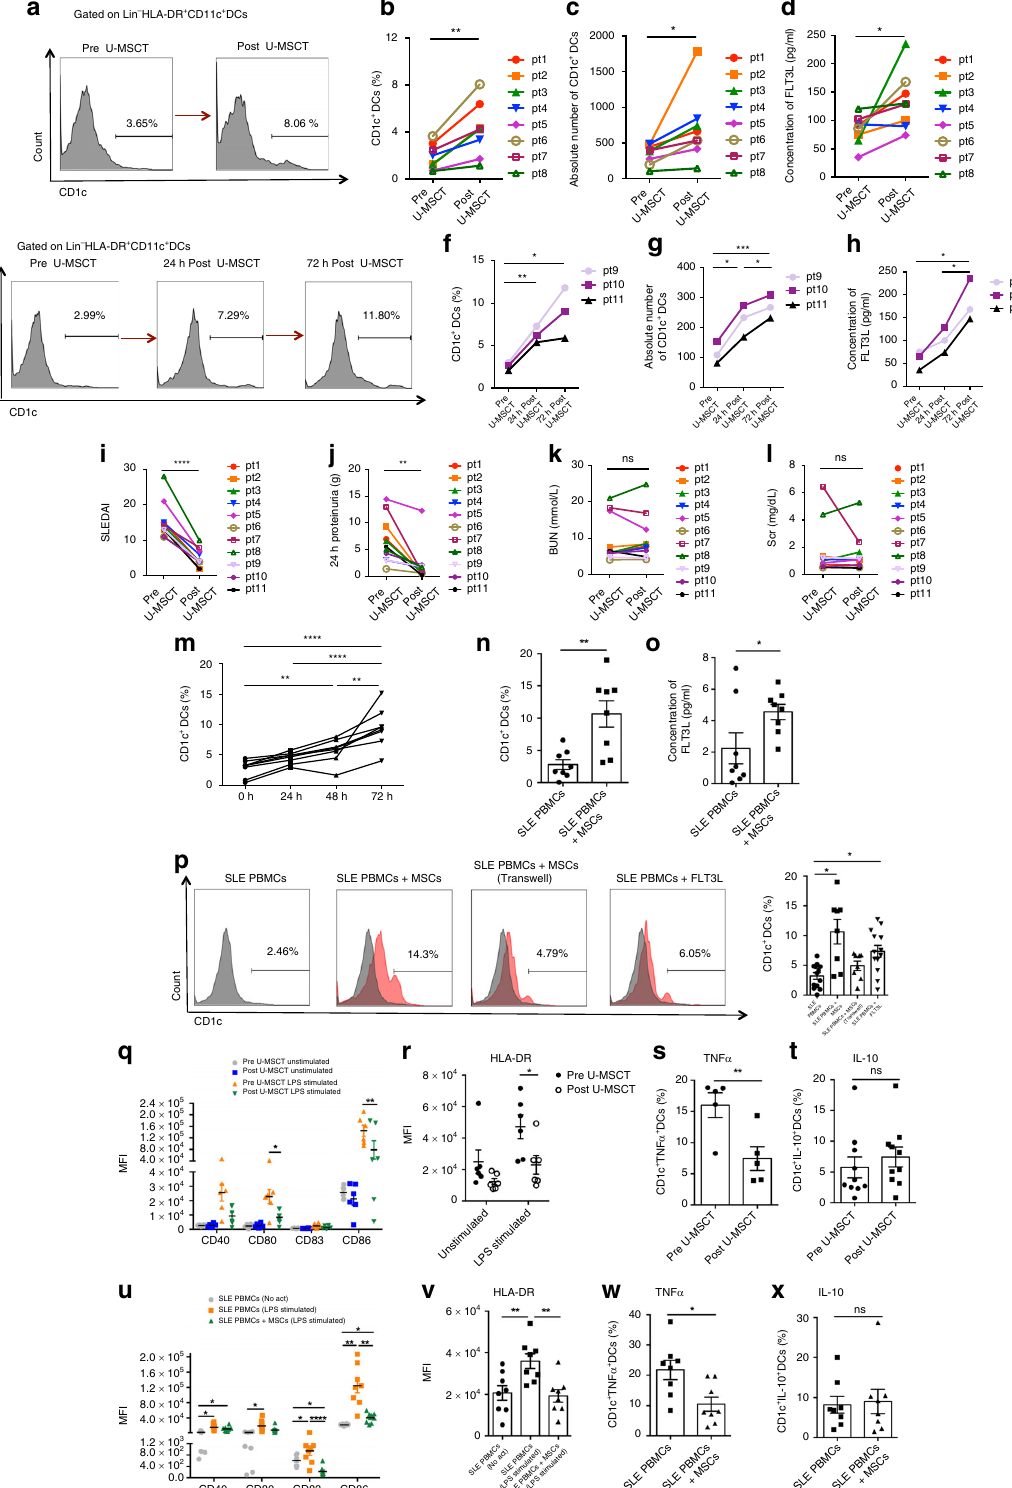
SLE patients decreased compared with healthy controls and RA patients (Supplementary Fig. 1), and the number of CD1c + DCs was negatively correlated with the SLEDAI score and LN-related indexes (Fig. 1e, f, g, h, i), indicating the crucial role of this tolerogenic DC subset in the pathogenesis of SLE, especially in patients with renal